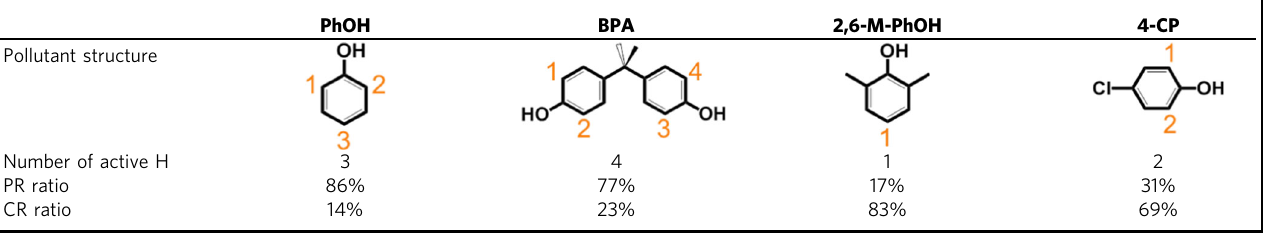
Figs. S31 – S33), radical quantitation fl uorescence detection (Fig. 4i